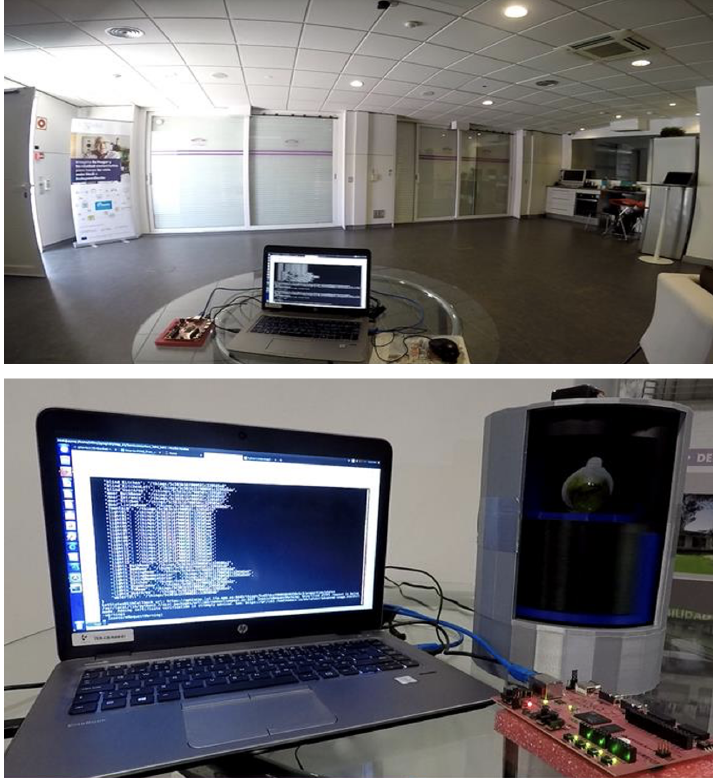
Figure 11. Field Programmable Gate Array controlling KNX ® devices (upper image) and an IoT device (lower image) via